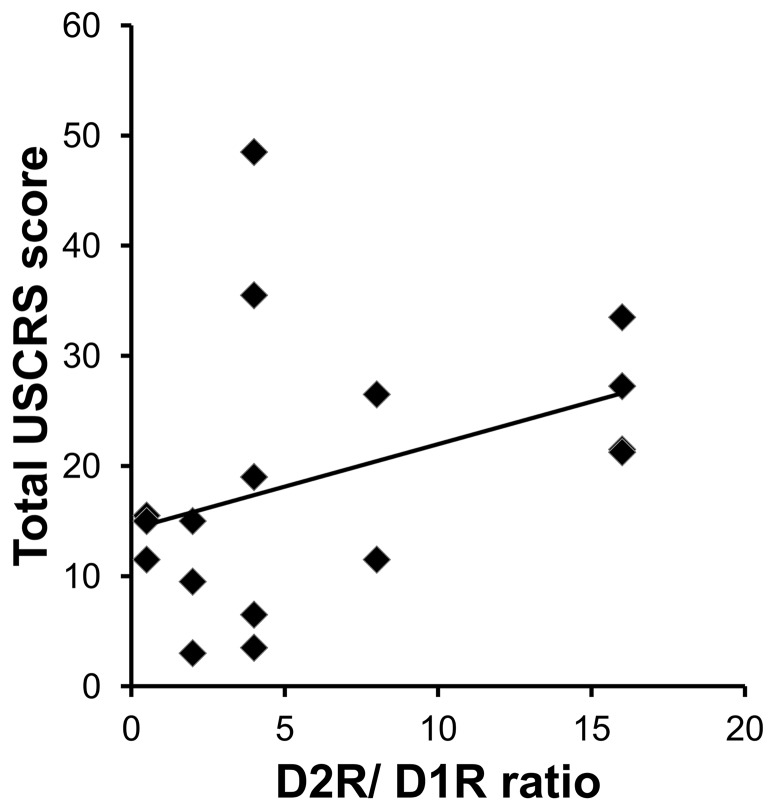
Dopamine receptor antibody ratio (D2R/D1R) correlates with neuropsychiatric symptoms (USCRS score).Autoantibody ratio against dopaminergic receptors correlated with the clinical motor and non-motor symptoms. Total USCRS ratings (n = 18, mean 19.1±11.9) correlated with anti-D2R/anti-D1R ratio (r = 0.53, P = 0.024) suggesting that the receptor imbalance may lead to dopaminergic hypersensitivity causing the clinical neuropsychiatric symptoms.